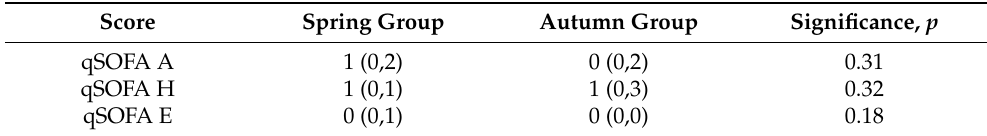
Table 3. qSOFA scores in the two groups: median values and interquartile